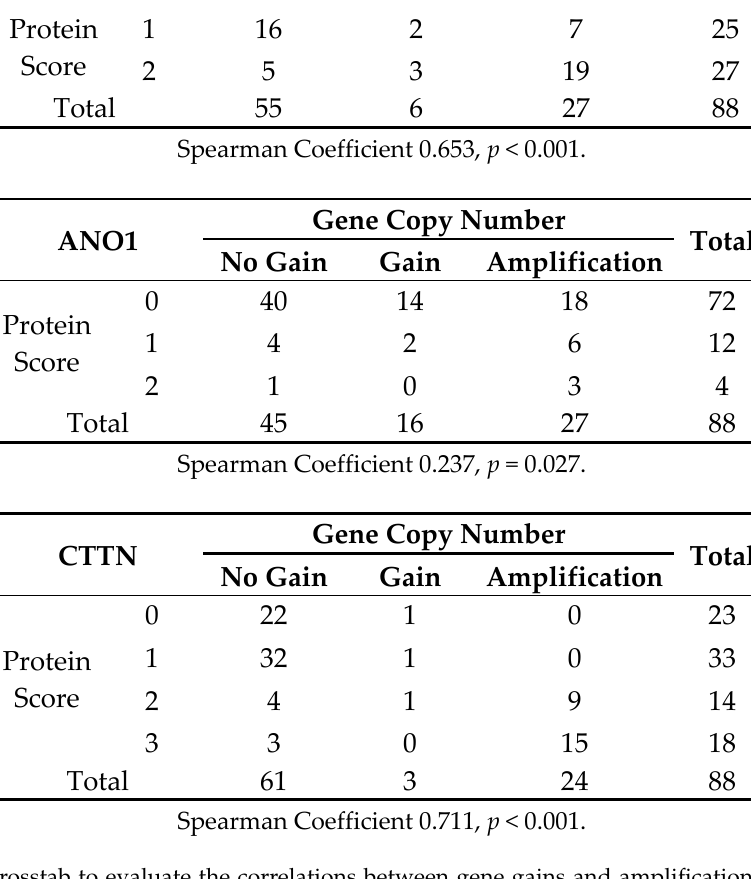
Figure 3. Crosstab to evaluate the correlations between gene gains and amplification and protein staining scores for CCND1, ANO1, and CTTN.